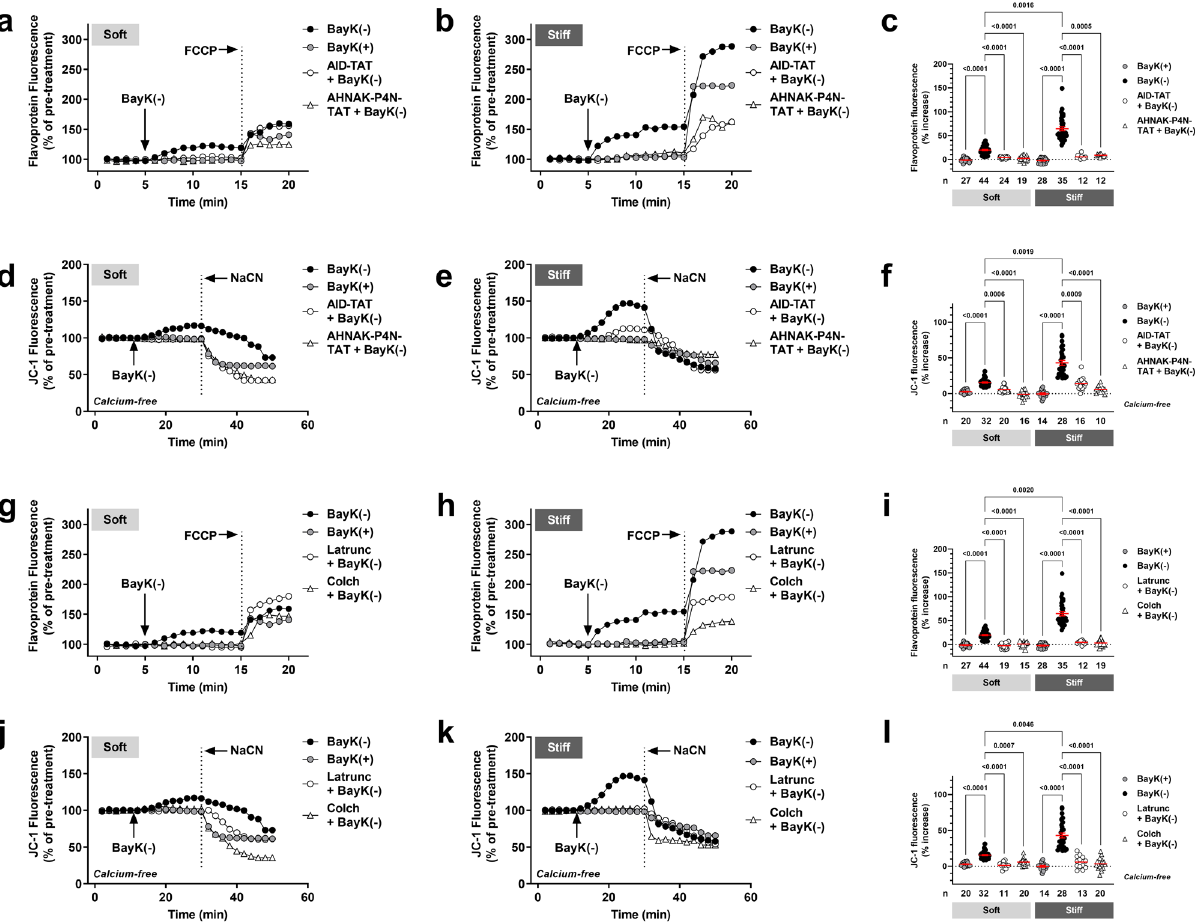
Fig. 3 A key structural – functional network between the cardiac L-type calcium channel and mitochondria assists in regulating mitochondrial function under conditions of varying substrate stiffness. Representative ratiometric fl avoprotein ( a , b and g , h ) and JC-1 ( d , e and j , k ) fl uorescence recorded from